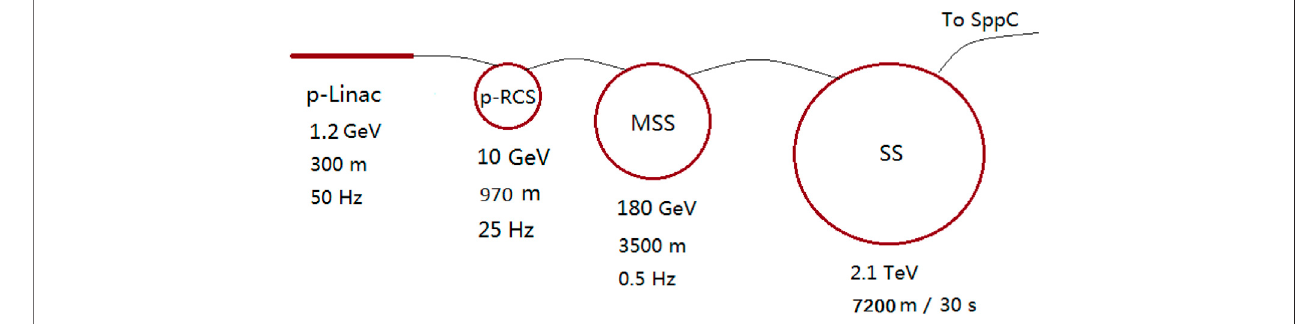
FIGURE 10 | Injector chain for the SPPC.